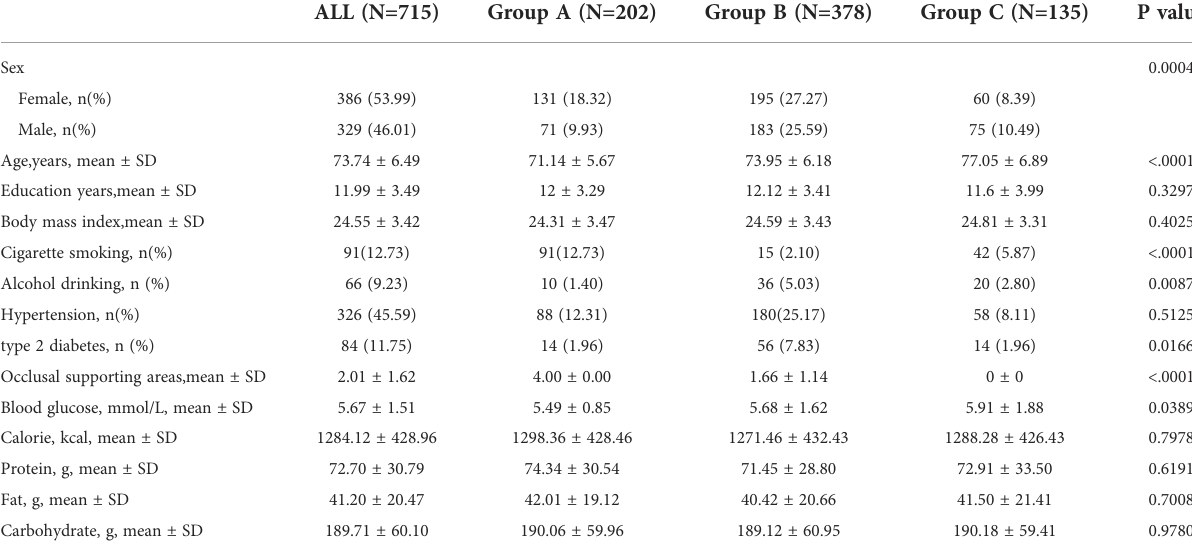
TABLE 1 Demographic, life style, and medical history of the participants with different Eichner classi fi